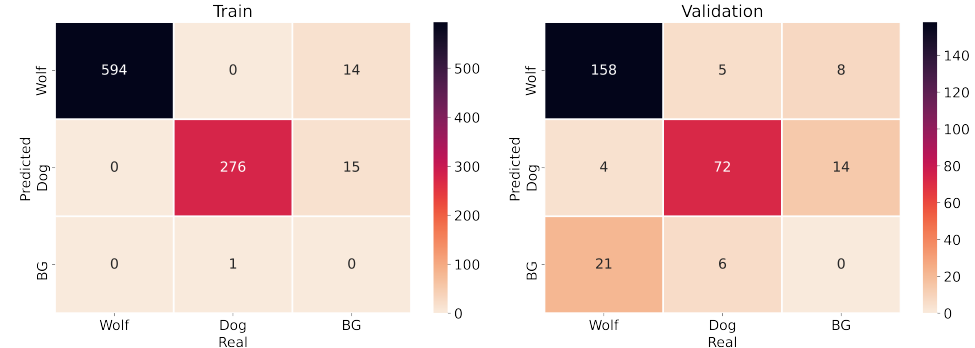
Figure 11. Confusion matrix for training ( left ) and validation ( right ) of YOLOv5m.